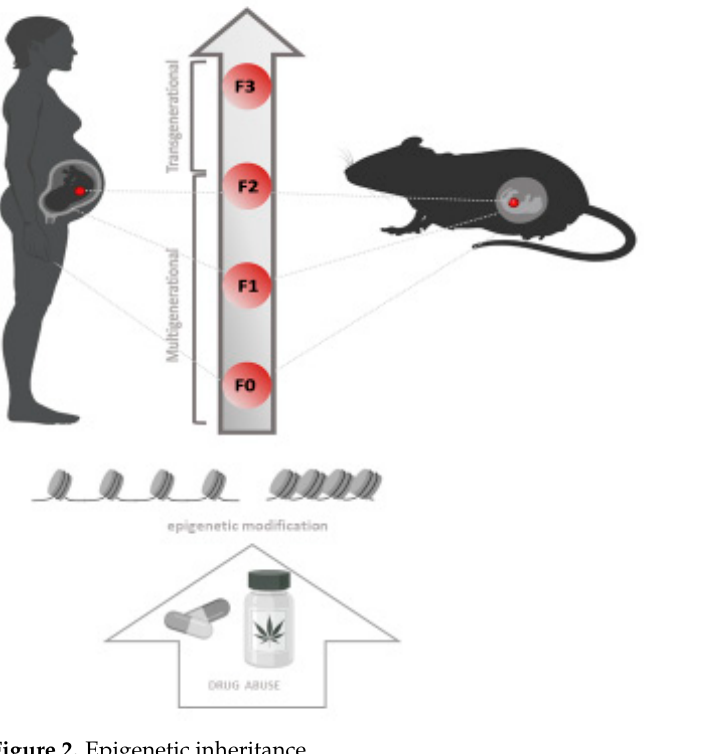
Figure 2. Epigenetic inheritance.